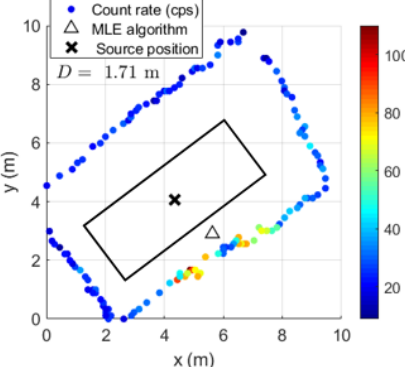
Figure 26. EJ-200 scintillator gamma-ray count rate (cps) measurements with detection system coupled with the drone considering Troxler equipment oriented 90 ◦ (shielded 215 MBq 137 Cs source— safe position) in the center of the shipping container. The distance “D” between the real source position and the estimated position (MLE algorithm) is also given.